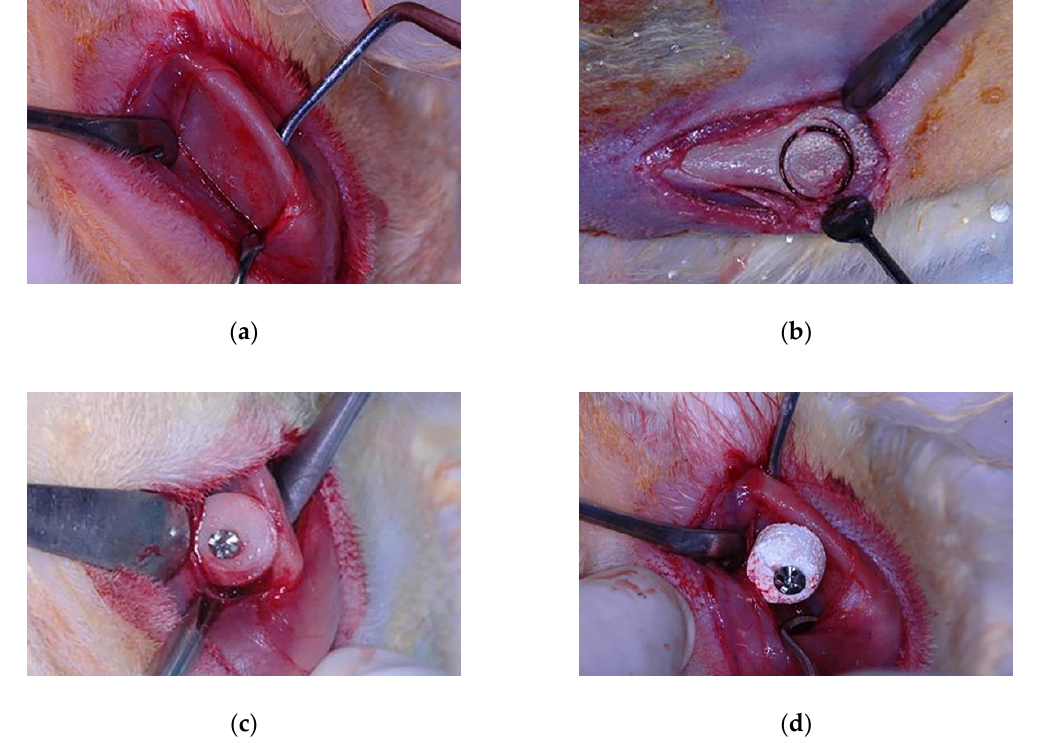
Figure 1. Experimental surgery procedure: ( a ) Surgical exposure of the recipient bed; ( b ) Autogenous bone block grafting procedure; ( c ) Autogenous block grafted in the autogenous group; ( d ) Biomaterial block grafted in the biomaterial group.